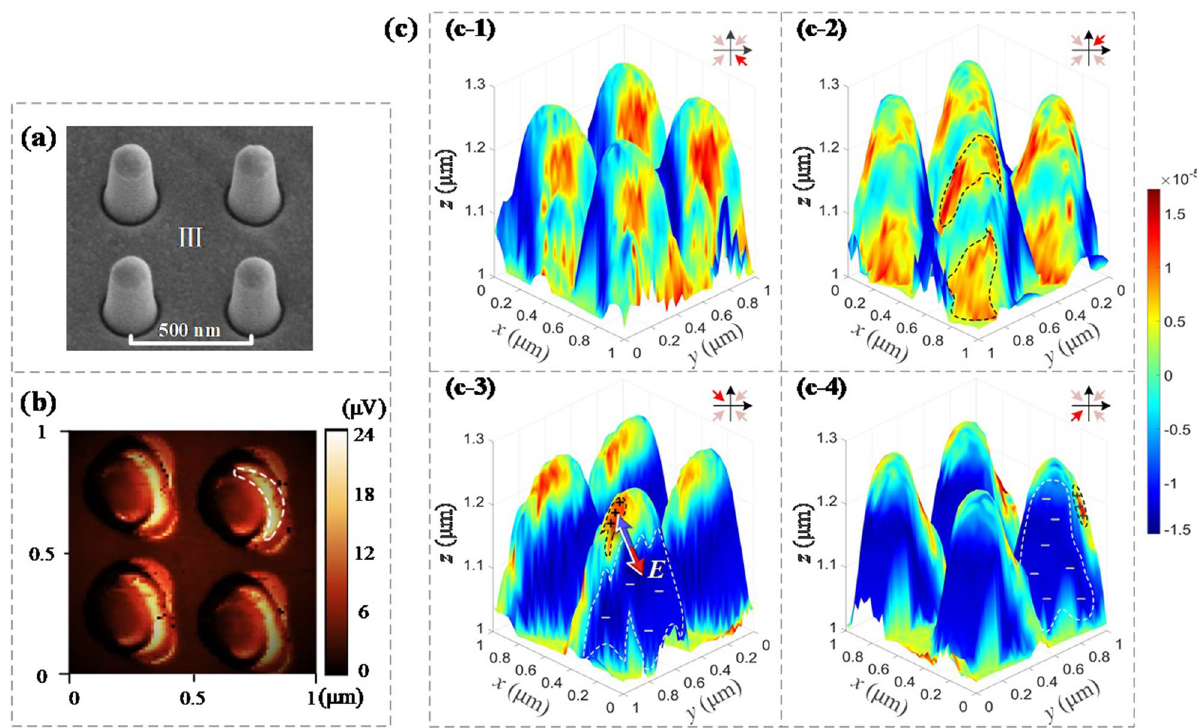
Figure 5. Typical surface net charge distribution of the GGNCT-III fabricated. ( a ) The SEM morphology of the GGNCT-III arrays. ( b ) The near-field light signal scanned by the probe, and the light color represents the strong signals and the dark color the weak signals. ( c ) Several typical 3D presentations about the surface net charge distribution according to different perspectives at − 45°, 45°, 135°, and − 135°, are exhibited in ( c-1 )–( c- 4 ). Several small regions colored red and blue are filled by the net positive and negative charges, respectively. A detailed arrangement of a dipole of net charges over the sidewall of each GGNCT excited by the incident polarized light vector E labeled by an arrow is also indicated in ( c-3